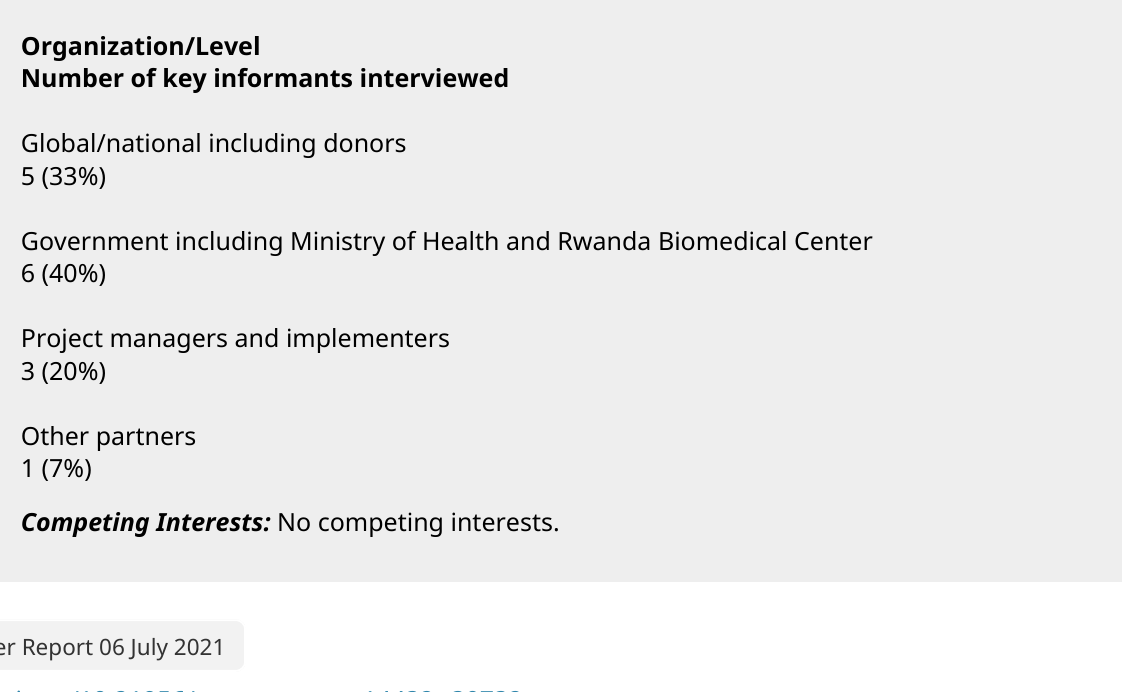
Table 2. Rwandan key informants